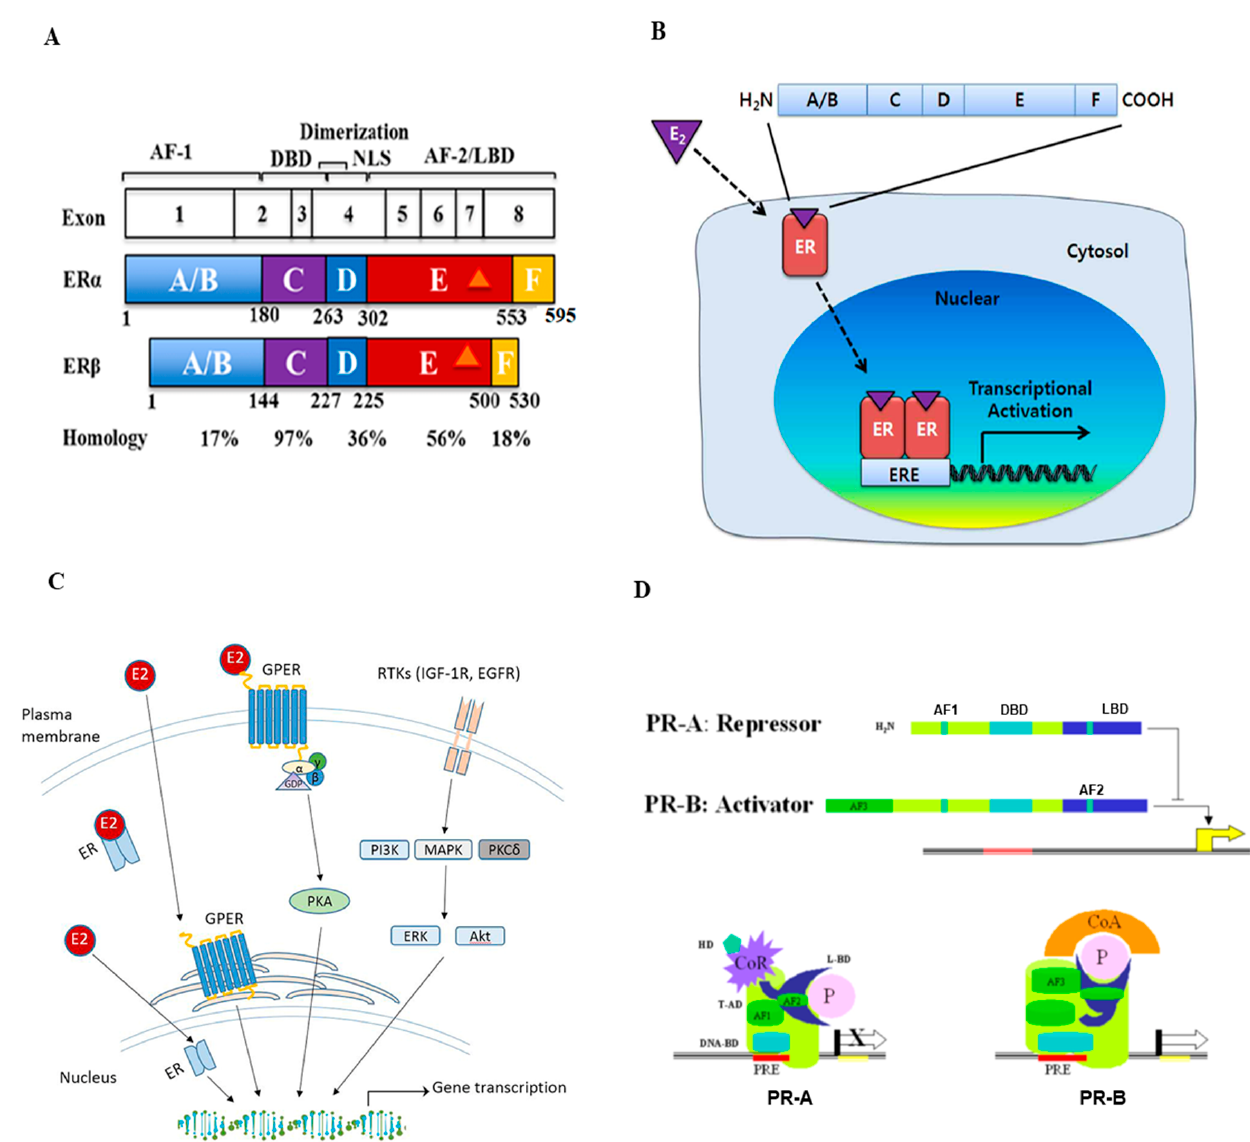
Figure 1. Structure and signal transduction of estrogen receptor (ER) and progesterone receptor (PR). ( A ) Schematic representation of the ER structural regions. Both ER α and ER β genes are expressed from 8 exons and have five interconnected segments of functional domains. The number of amino acids and percent homology between the two ERs for each segment are indicated (Figure reproduced from [11]). ( B ) Mechanisms of estrogen receptor signaling pathway. Estrogen (E2) first binds ERs, then ERs dimerize and translocate into the nucleus. These complexes bind to estrogen response elements (EREs) and regulate downstream gene transcription (Figure reproduced from [10]). ( C ) Schematic overview of estrogen and G-protein coupled estrogen receptor (GPER) interaction and activation in estrogen signaling pathways. The GPER is an alternate ER with seven-transmembrane domains that mediate nongenomic estrogen-related signaling. Membrane estrogen can interact with GPER, which further activates downstream protein-kinase cascades (Figure reproduced from [18]). ( D )